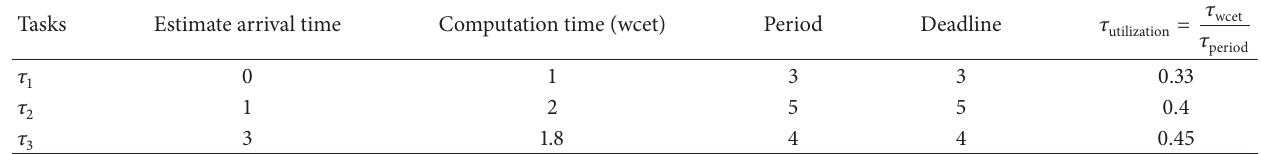
Table 2: Arrival time, wcet, period, and deadline of tasks 𝜏 1 , 𝜏 2 , and 𝜏 3 .